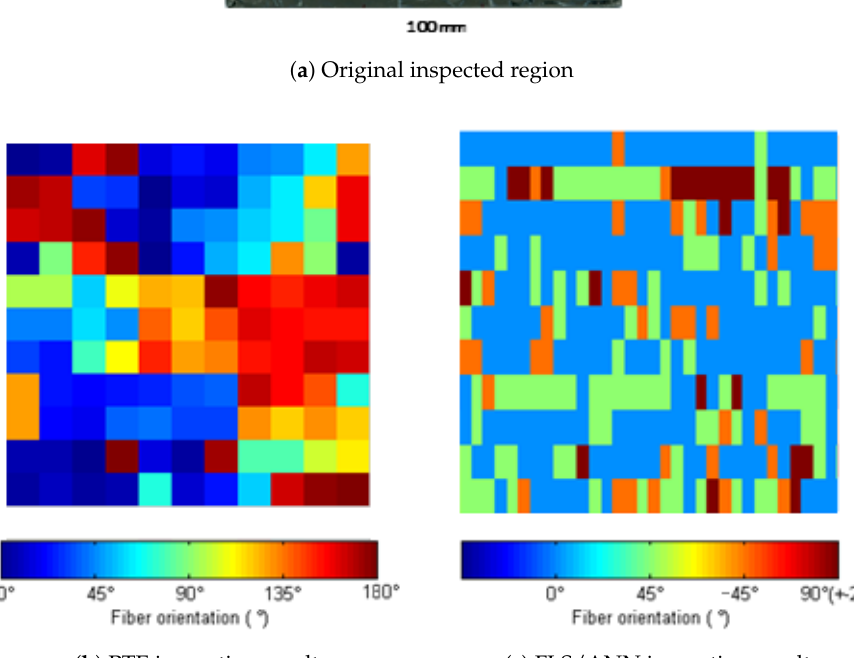
Figure 11. Comparison of point-by-point PTE inspection and the proposed FLS/ANN approach. ( a ) The inspected ROS region, ( b ) Results obtained with PTE inspections and ( c ) results calculated with the ANN for the FLS inspection for the same